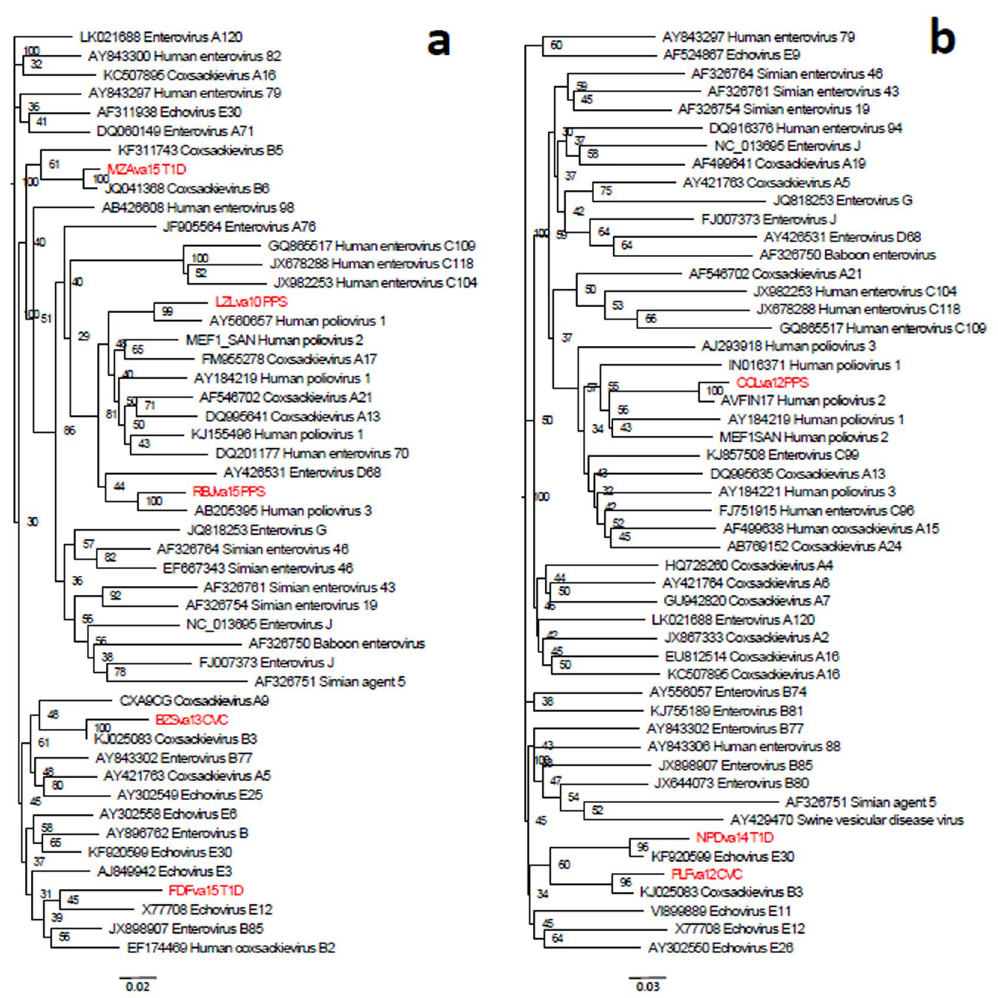
Figure 3. Phylogenetic analysis of nucleotide sequences of a part of the 5 ′ -UTR region (nucleotides 345–607, panel a) and a region covering the distal part of 5 ′ -UTR, VP4 and the proximal part of VP2 (nucleotides 580–1170, panel b) determined for PCR amplicons. Sequences determined for PPS, T1D, and CVC cases are shown in red. Homologous regions from a selected set of 50 published reference enterovirus sequences